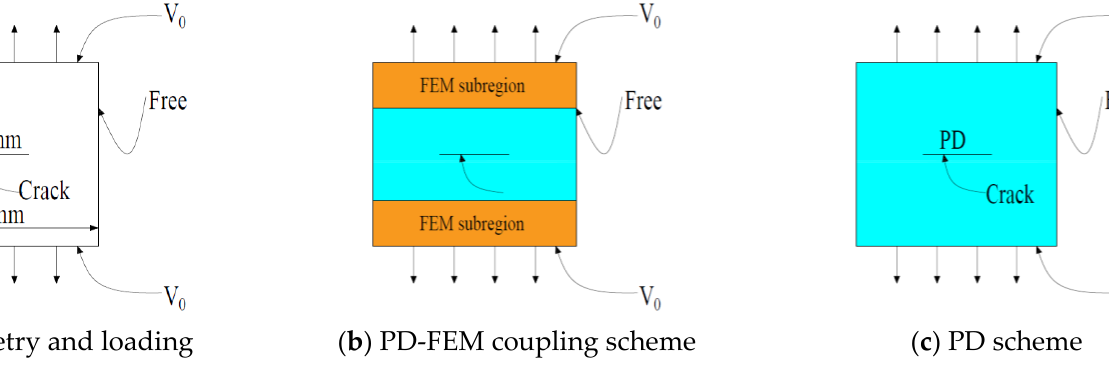
Figure 6. Geometry and loading condition of a plate with a central crack.